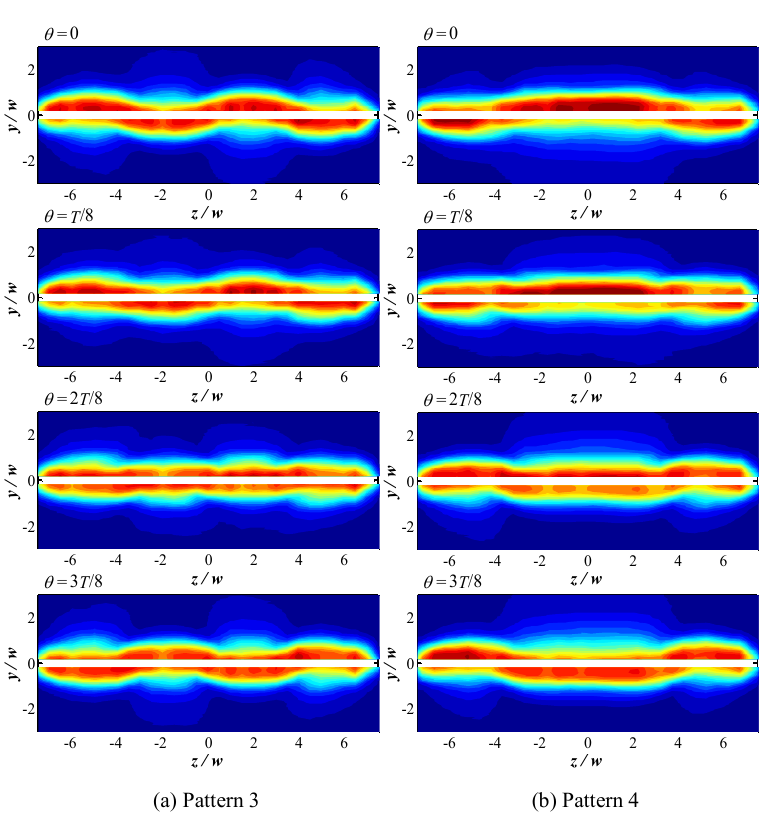
Fig.10 Contour maps of 0 /))(~ ( UuU θ+ with control. x/w =4.25, Contour spacing are 1.0 × 10 -2